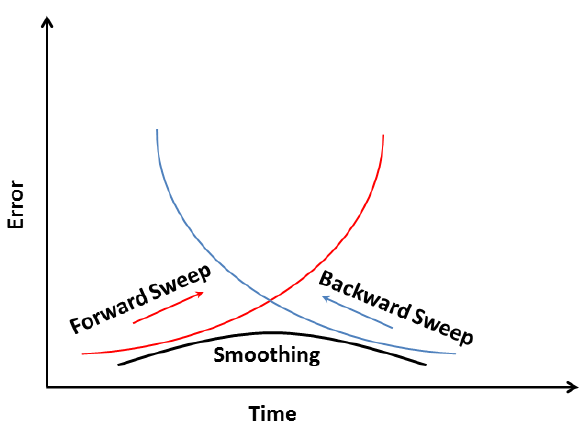
Figure 5. The effect of the RTS